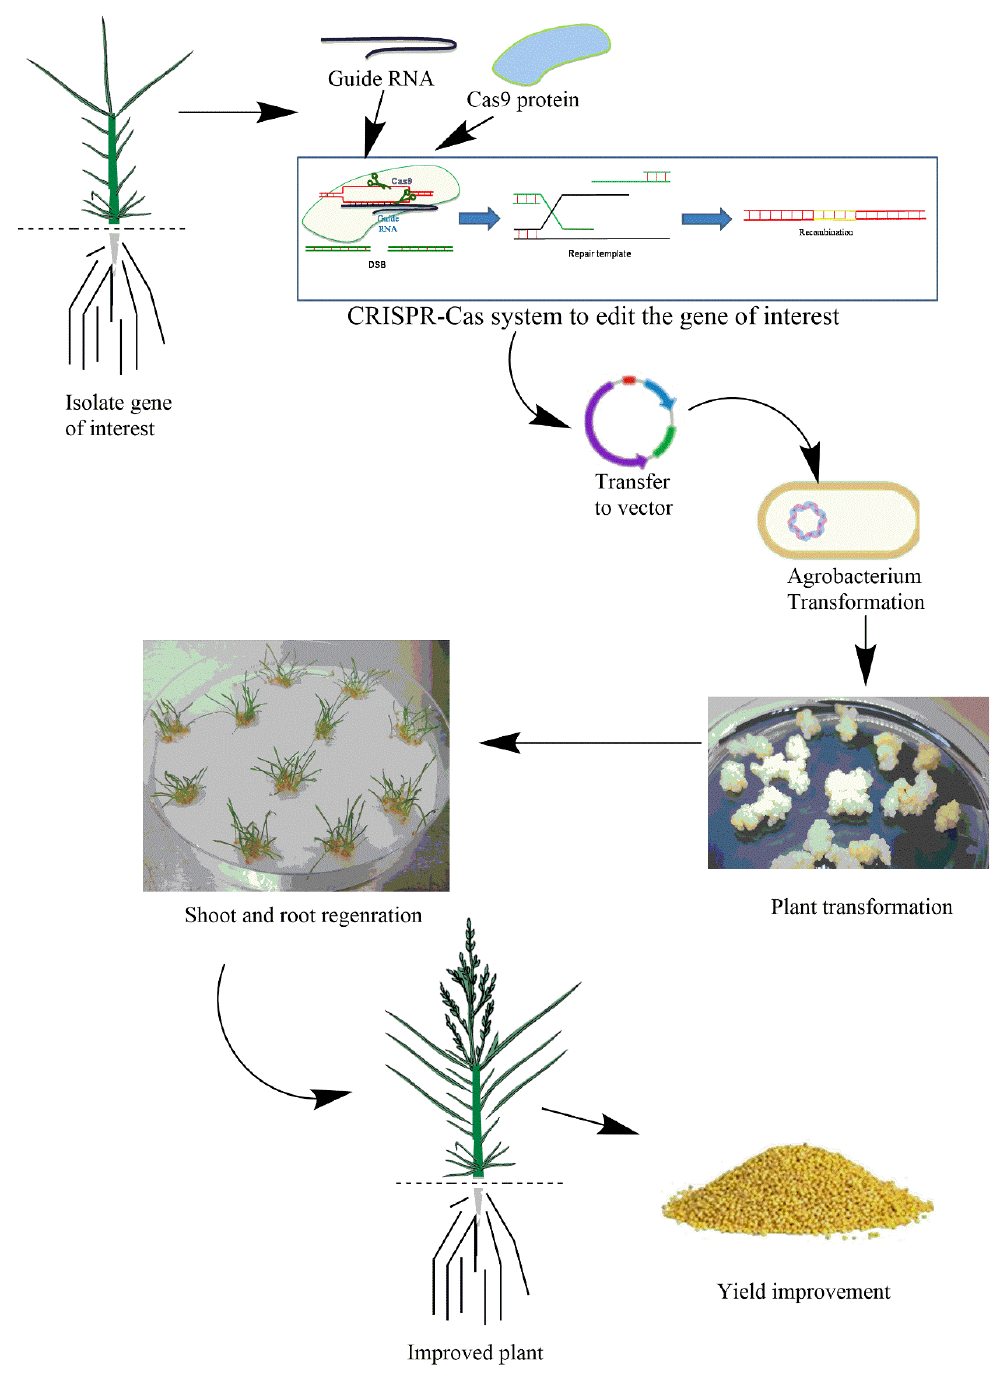
Figure 2. Illustration of CRISPR/Cas9 application in genome editing for yield improvement and stress mitigation. For CRISPR/Cas9 gene editing, a guide RNA (gRNA) is designed from a gene of interest, such as those listed in Table 2, and inserted into a binary vector. A bacterial CAS9 Nick-ase enzyme (Cas9) protein is also inserted into a binary vector. The gRNA and Cas9 expression cassettes are then used for Agrobacterium -mediate transformation for trait improvement. The fox-tail millet plant is used as a new model plant for CRISPR/Cas9 editing